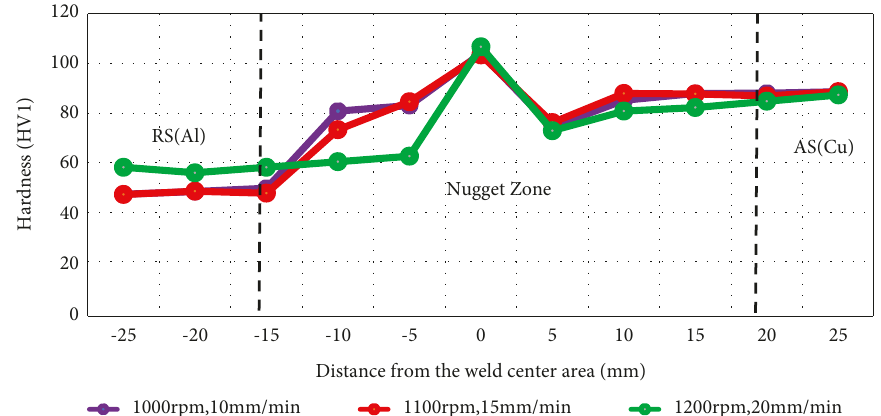
Figure 15: The microhardness distribution of welded joints at different tool rotation speeds and feed